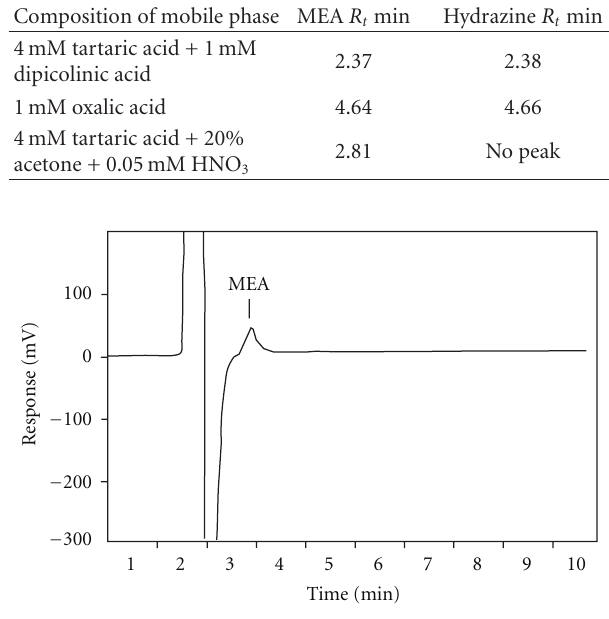
Figure 1: Chromatogram of a synthetic mixture of MEA (2 µ gmL − 1 ) and hydrazine (20 µ gmL − 1 ) showing only the MEA peak resolved from the large injection